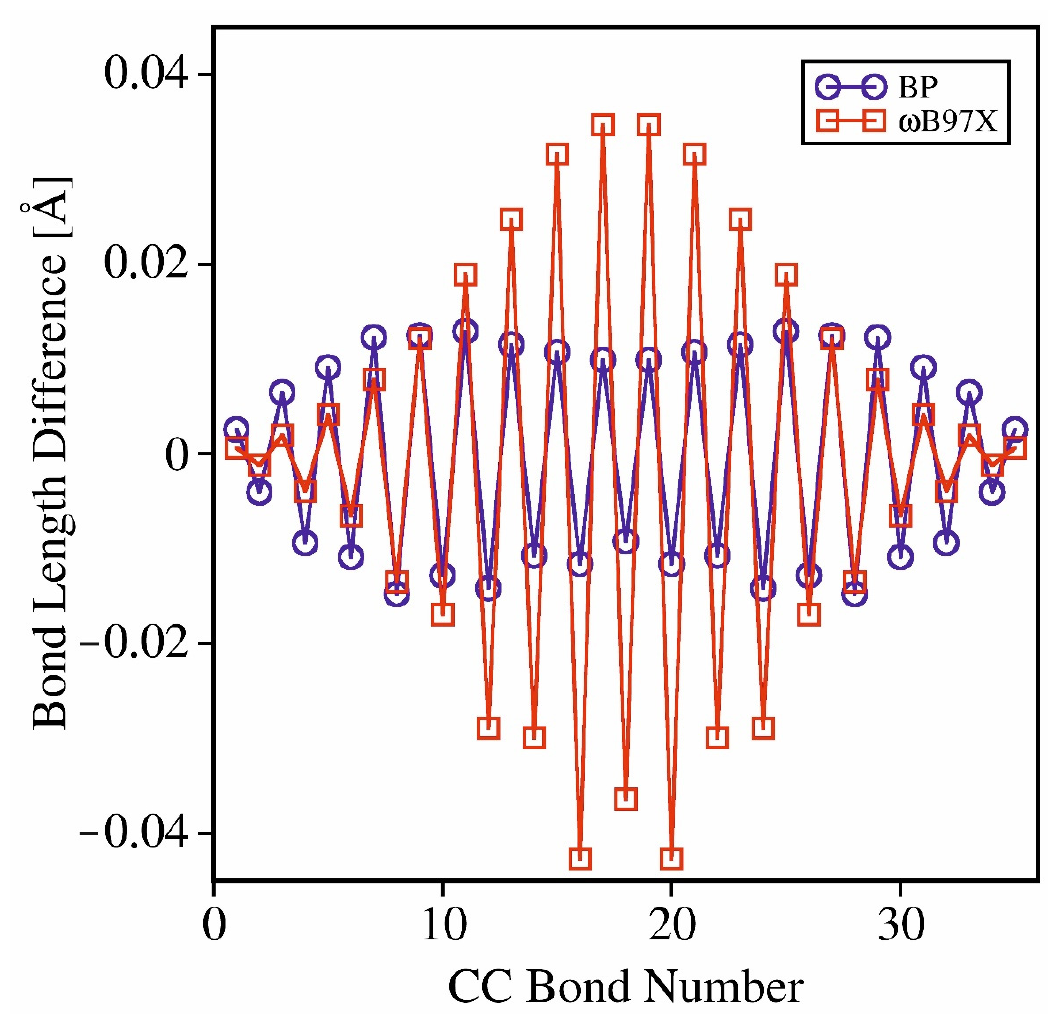
Figure 3. Respective CC bond length differences along the carbon skeleton of 9O, caculated for the excited and the ground electronic states using the pure DFT functional and the range-corrected functional containing up to 100% of the non-local exchange. Table 2. Vertical emission energies calculated for the studied oligofurans using the selected vari- ants of DFT/TDDFT and the CC2 method with the def2-TZVPP basis set.